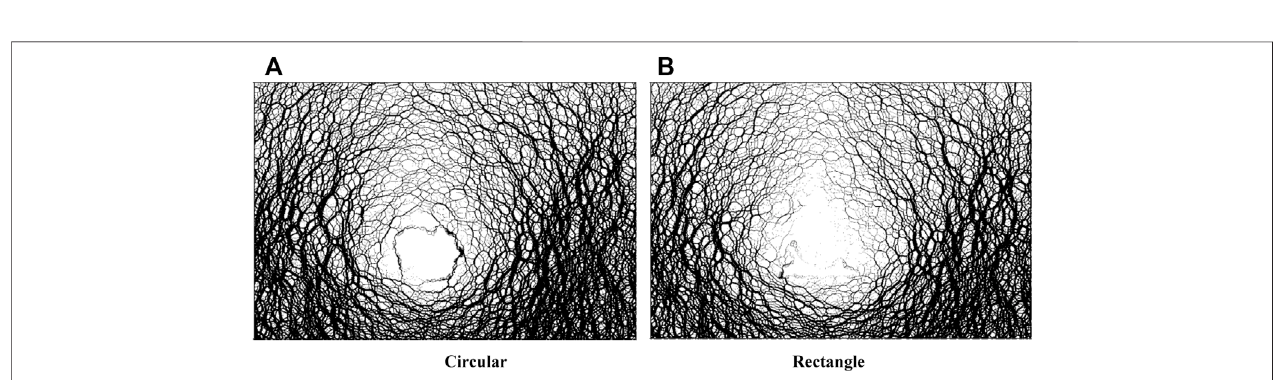
FIGURE 4 | Force chain patterns of circular tunnel with diameters of 4, 8, and 12 m after earthquake. (A) Diameters of 4 m. (B) Diameters of 8 m. (C) Diameters of 12 m.